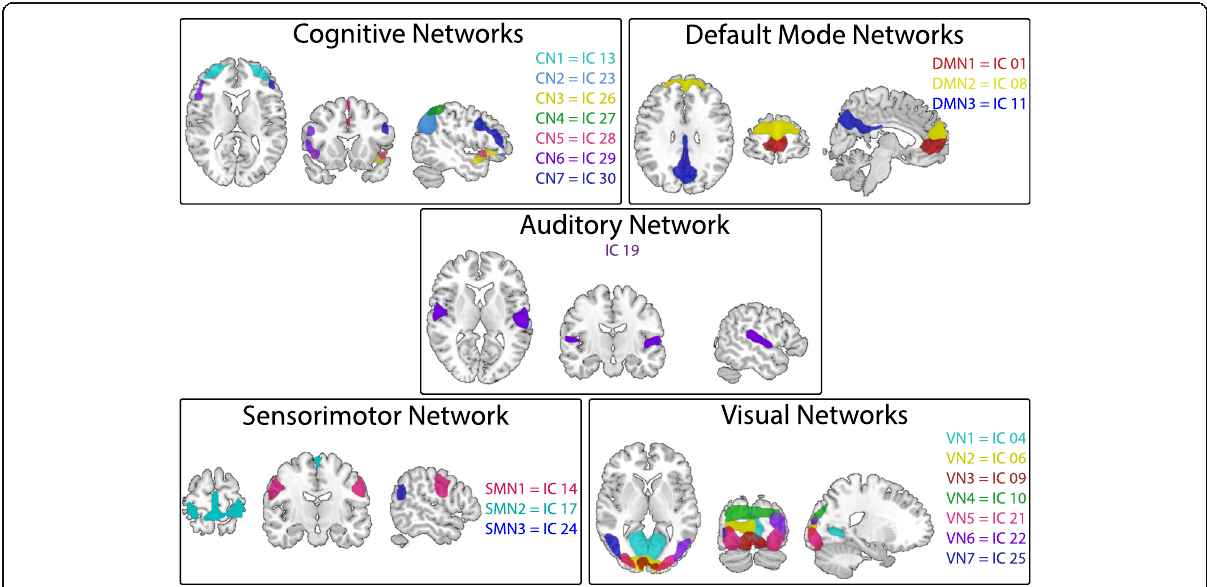
Fig. 1 Spatial maps of the 19 independent components (IC) identified as resting-state networks, grouped with their respective networks based on anatomical location. Components are plotted as z-statistics, thresholded at 3.0. CN: Cognitive Network; DMN: Default Mode Network; SMN: Sensorimotor Network; VN: Visual Network